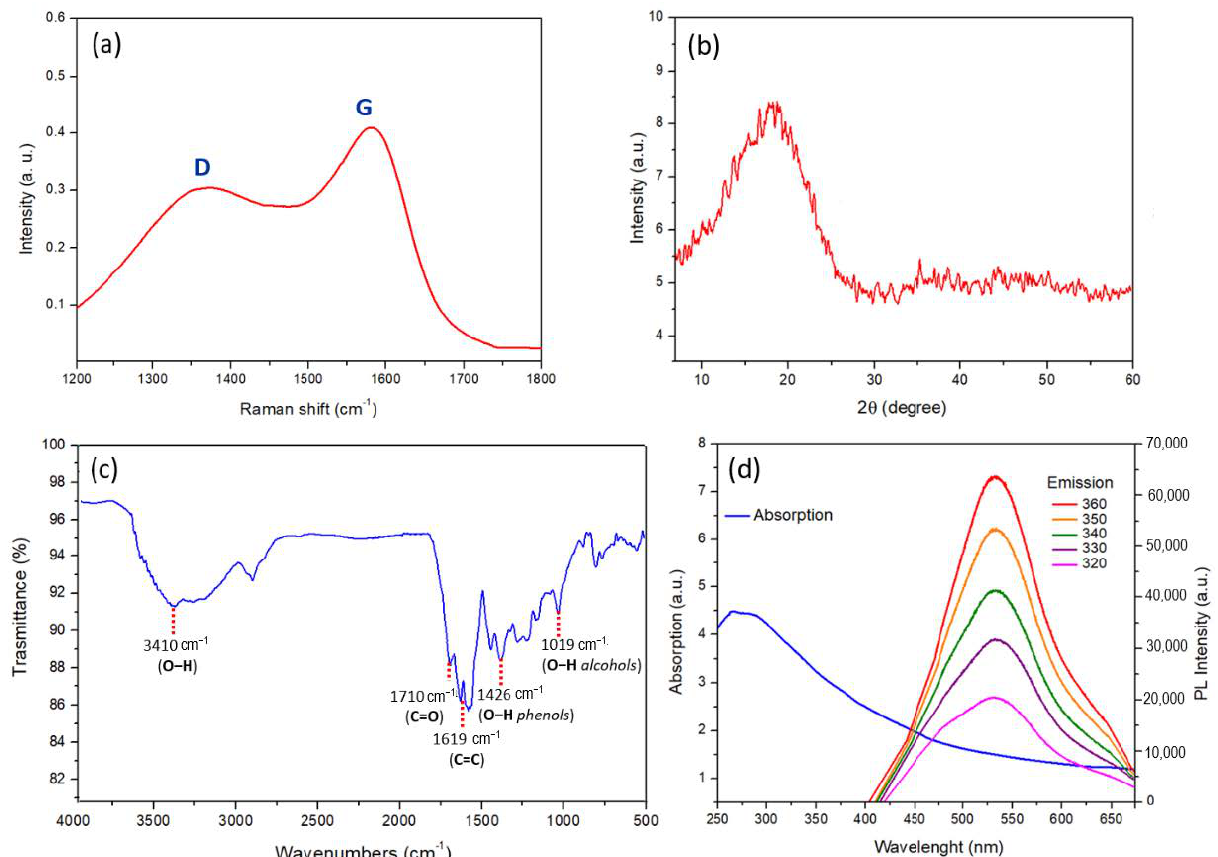
Figure 5. ( a ) Raman spectrum of NBC recorded at λ = 532 nm; ( b ) XRD spectrum of NBC; ( c ) ATR-FTIR spectrum of NBC; ( d ) optical properties of NBC dispersion in deionized water: UV‒vis absorption spectrum (blue line) and PL spectrum at the λ exc of 320 – 360 nm.